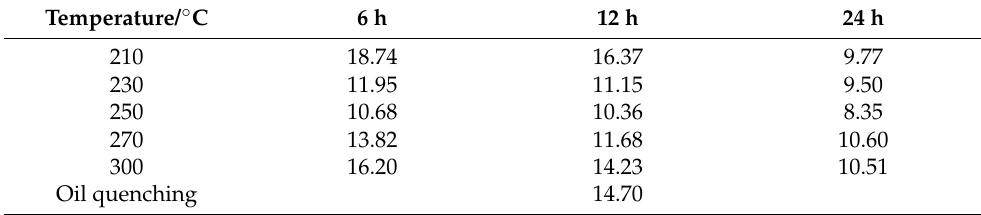
Figure 2. Light optical microstructures under different processes (( a – c ) are at 230 ◦ C for 6 h, 12 h, and 24 h; ( d – f ) are at 250 ◦ C for 6 h, 12 h, and 24 h; ( g – i ) are at 270 ◦ C for 6 h, 12 h, and 24 h, respectively). Table 2. The V γ under different processes (vol.%).